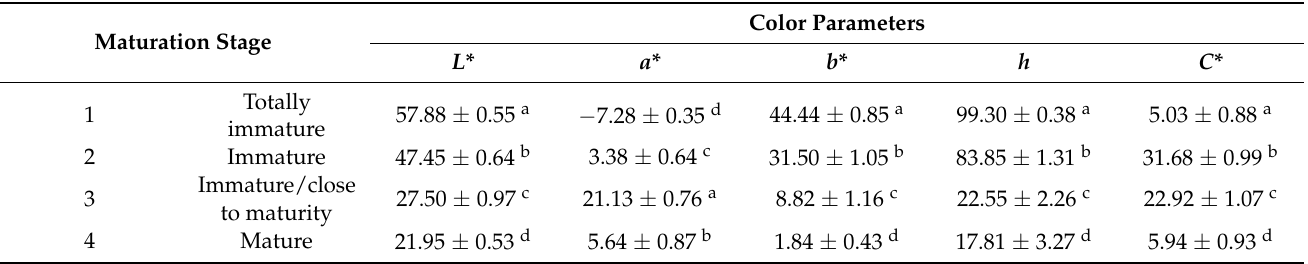
Table 2. Color parameters L *, a *, b *, h and C * for the four ripening stages of Vaccinum stenophyllum Steud. fruit.